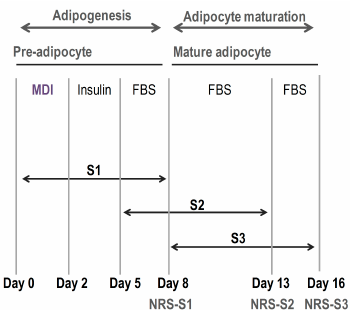
Figure 1. Scheme followed in the procedure to evaluate the effect of the treatments during different phases of the differentiation process: pre-differentiation/stage 1 (S1, from day 0 of the study to day 8), differentiation/stage2 (S2, from day 5 of the study to day 13) and post-differentiation/stage 3 (S3, from day 8 of the study to day 16), depending on the moment the compounds were added to the medium. Treatments were maintained during 8 days in every case, until Nile Red staining (NR) was performed at the three analytical points indicated (NRS-S1, NRS-S2 and NRS-S3).